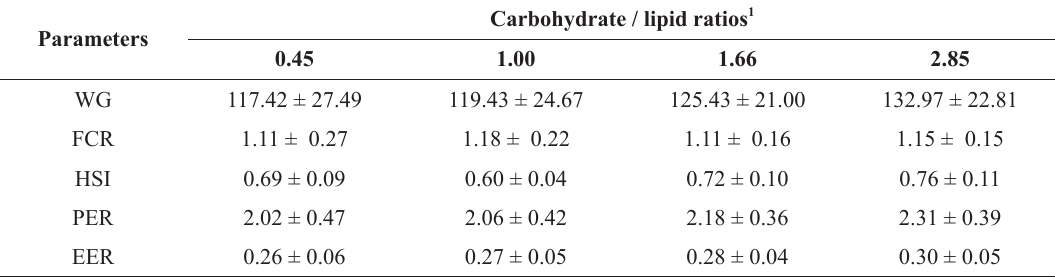
Growth performance, feed utilisation and Hepatosomatic Index of the juvenile Pseudoplatystoma ssp fed the experimental diets for 60 days. Lack of superscript letters in the same line implies no differences in data at